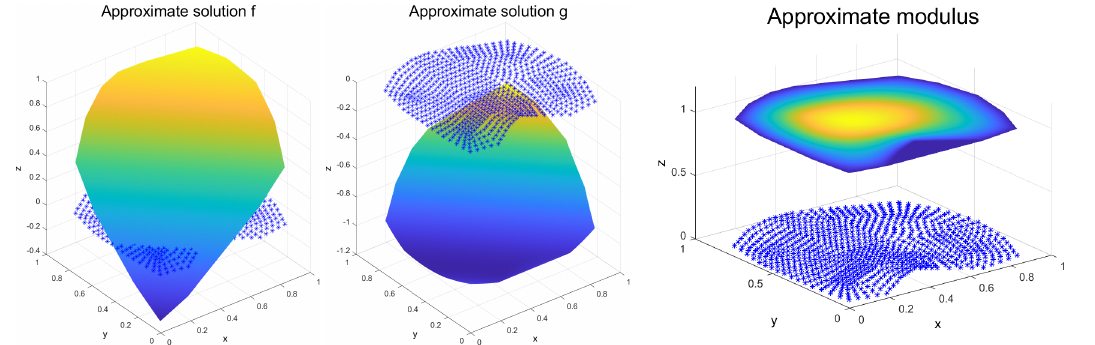
Figure 5. Approximate solutions in the Example 3.